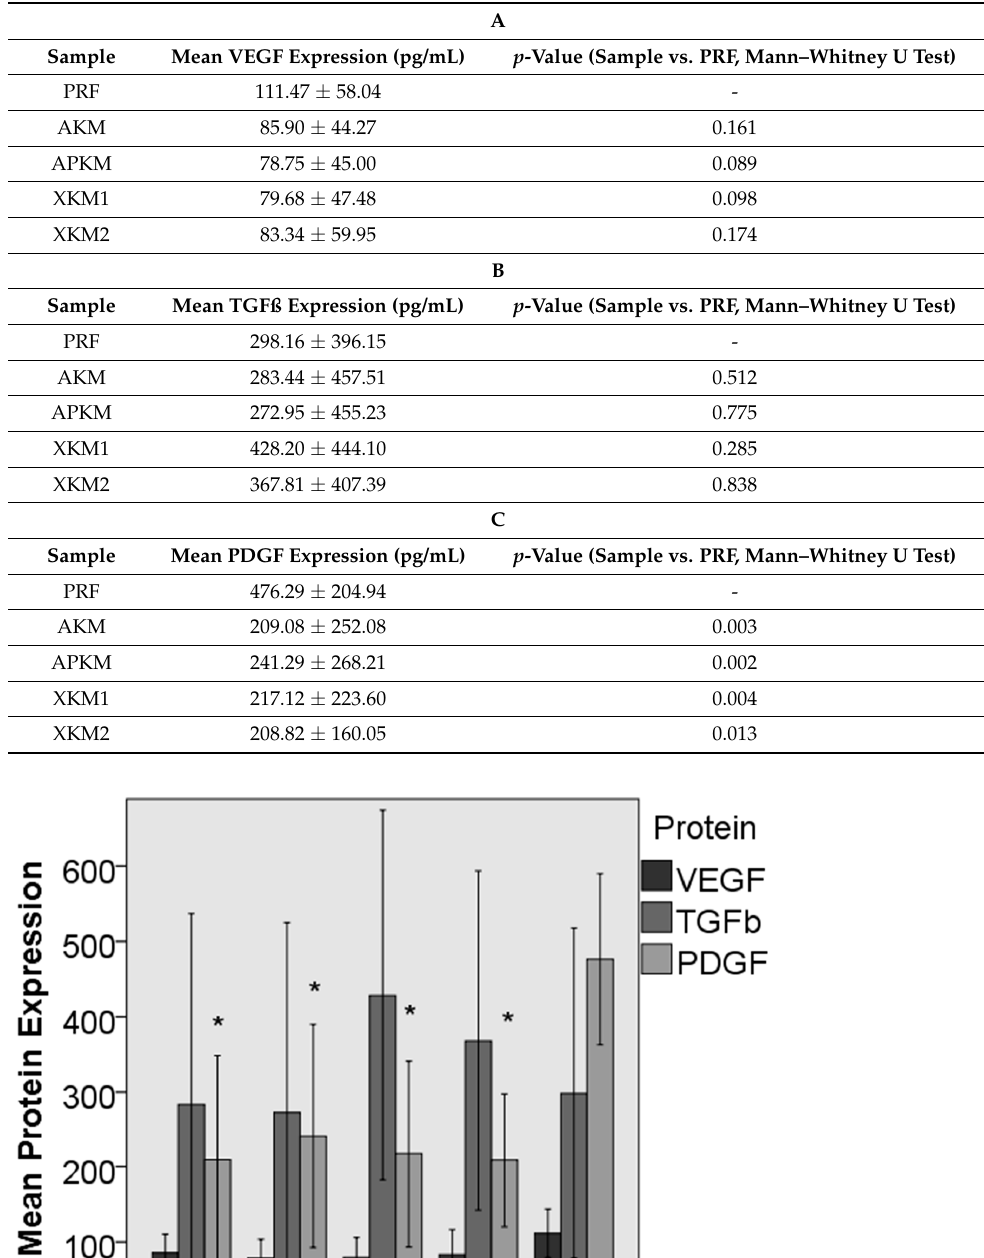
Table 2. Mean protein expression via ELISA for ( A ) vascular endothelial growth factor (VEGF), ( B ) tissue growth factor ß (TGFß) and ( C ) platelet-derived growth factor (PDGF) in pg/mL with standard error after 15 min of incubation of each BSM with PRF in comparison to PRF alone. p -values are given for the comparison of each sample with PRF alone (Mann–Whitney U test).